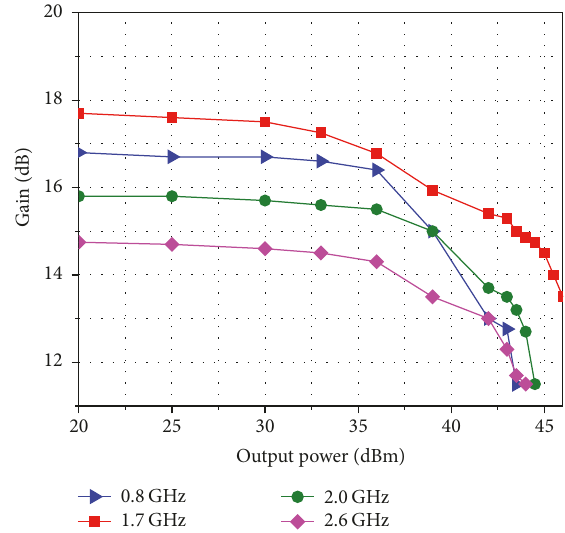
Figure 12: Measured gain versus output power at 0.8, 1.7, 2.0, and 2.6